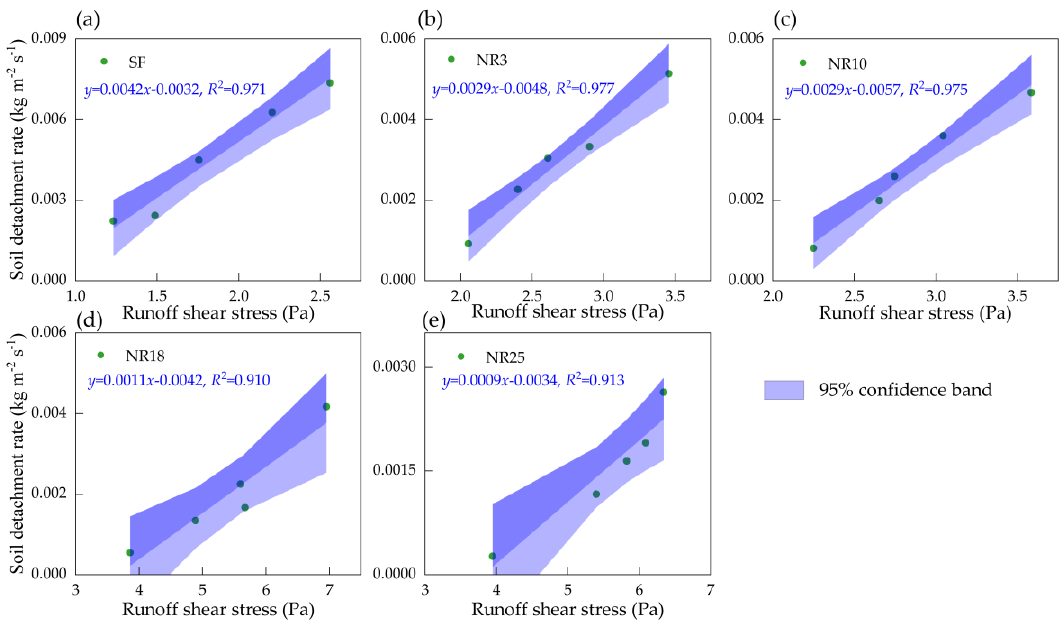
Figure 9. Relationship between soil detachment rate and shear stress under different revegetation ages. ( a ) SF; ( b ) NR3; ( c ) NR10; ( d ) NR18; ( e ) NR25.